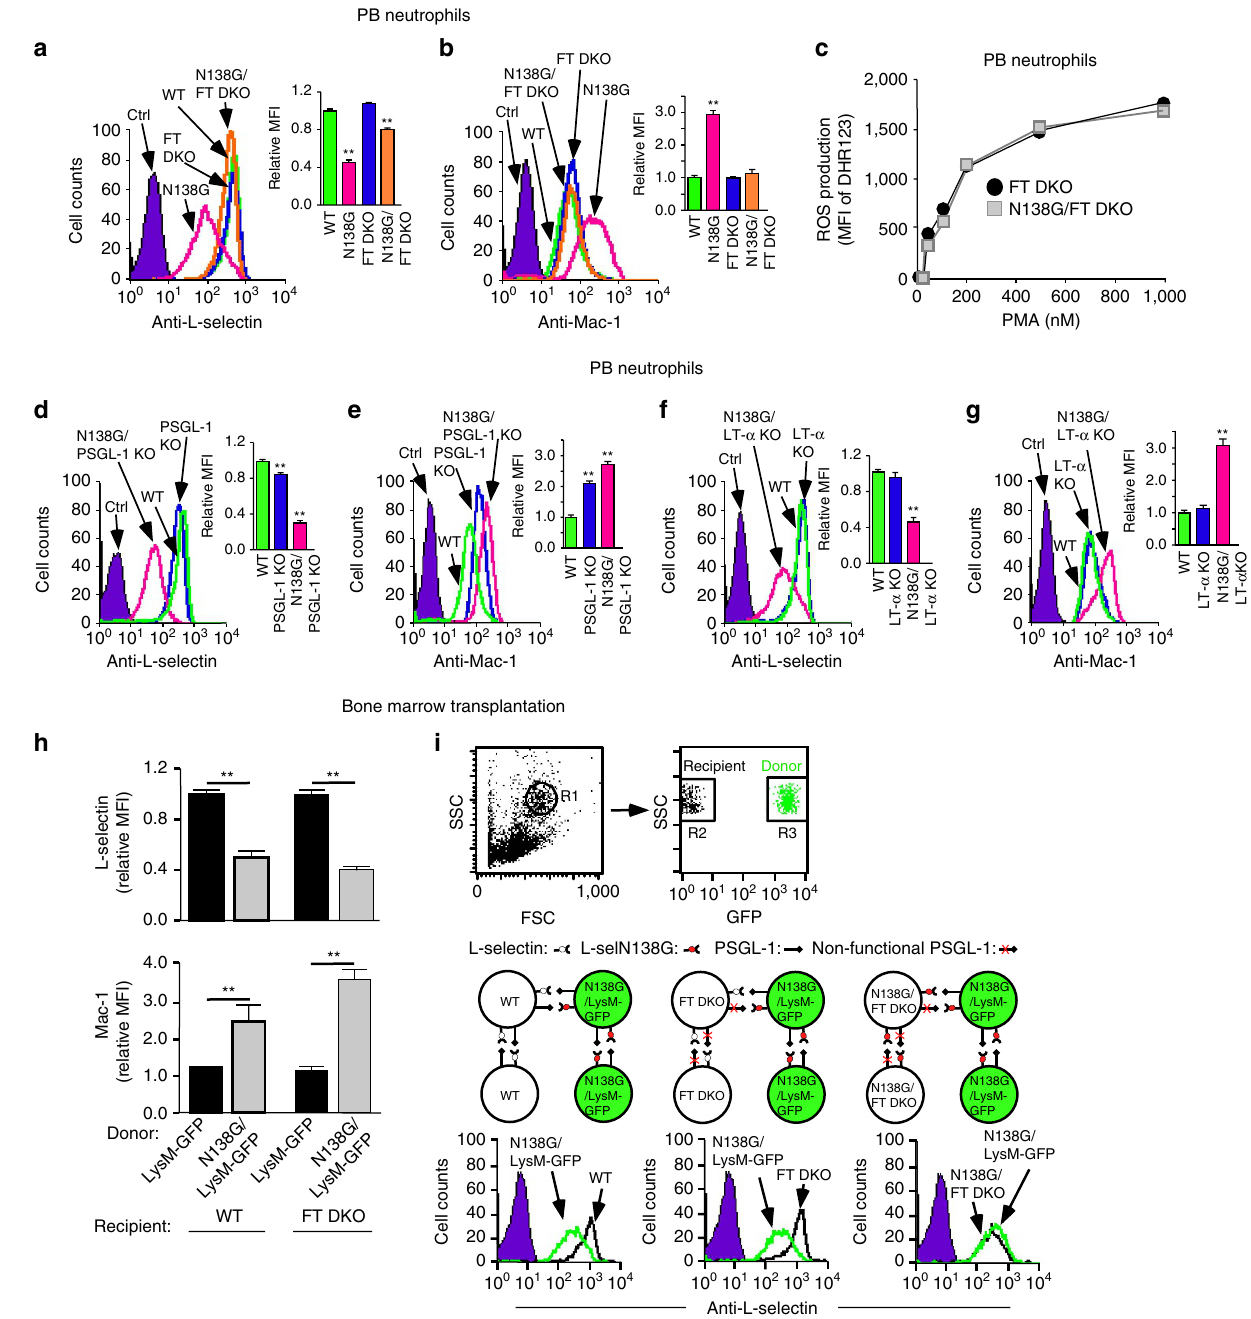
Figure 4 | Eliminating selectin ligands in N138G mice prevents priming of circulating neutrophils. ( a , b , d – g ) Surface expression of L-selectin and Mac-1 on PB neutrophils of the indicated genotype. Representative histograms and relative mean fluorescence intensity (MFI) in bar graphs are shown. The gating strategy for PB neutrophils is shown in Supplementary Fig. 9. ( c ) ROS generated by PB neutrophils from FT DKO or N138G/FT DKO mice in response to PMA. ( h ) Surface expression of L-selectin and Mac-1 on PB neutrophils from irradiated WTor FT DKO mice reconstituted with donor BM from LysM-GFP or N138G/LysM-GFP mice. ( i ) Surface expression of L-selectin on PB neutrophils from irradiated WT, FT DKO or N138G/FT DKO mice (black) partially reconstituted with donor BM from N138G/LysM-GFP mice (green). Top, PB neutrophil populations gated by forward and side scatter (R1) were analysed for fluorescence to distinguish GFP-negative recipient cells (R2) from GFP-positive donor cells (R3). Bottom, binding schematics and representative histograms. The data in a – h are mean ± s.e.m. of five mice per group. The data in i are representative of three mice per group. ** P o 0.01 (two-tailed Student’s t